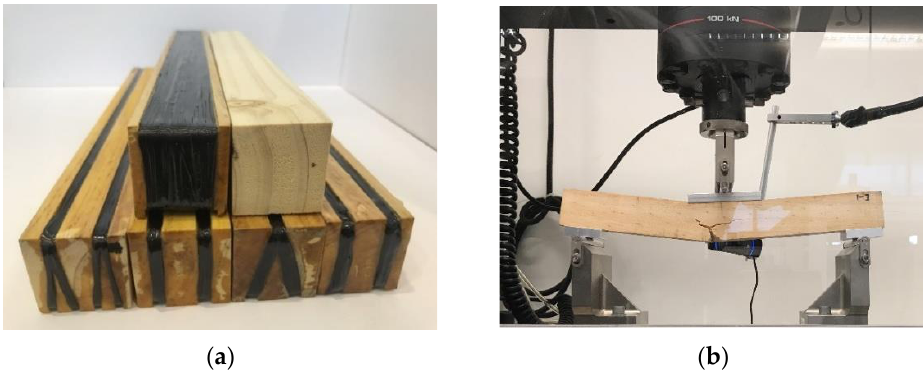
Figure 3. ( a ) Some of the radiata pine sample pieces ready for testing. ( b ) Experiment setup showing reaction-bearing plates used at supports and between the loading anvil and the sample.